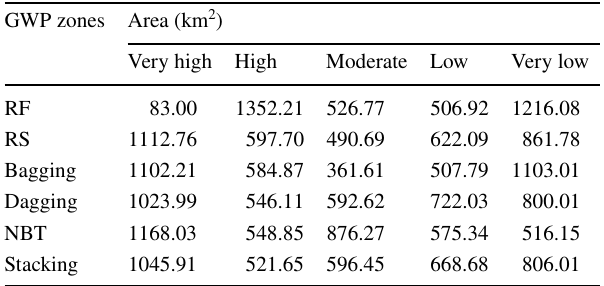
Fig. 5 The EML algorithms based GWP models, such as a RF, b RS, c bagging, d dagging, e NBT, and f stacking Table 5 Calculation of area of five GWP zones using six EML mod-